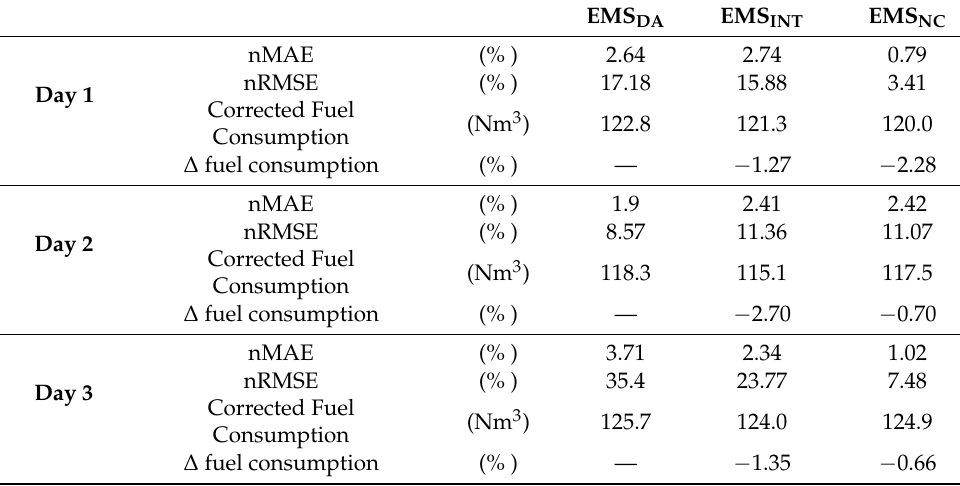
Table 6. Summary of experimental and simulated